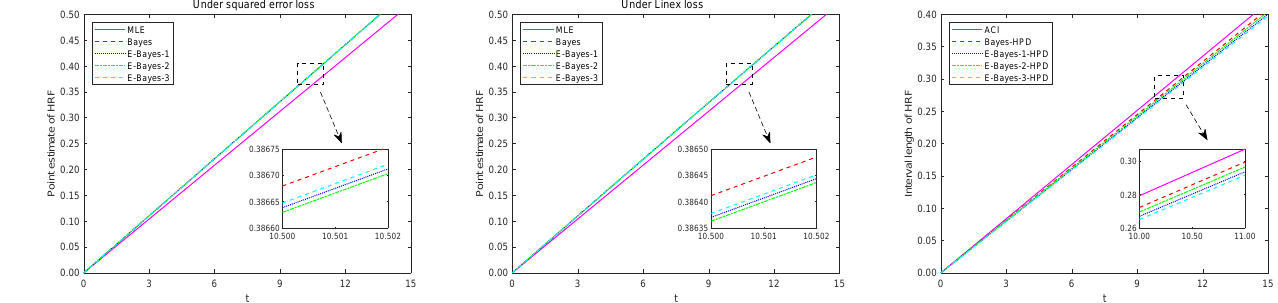
Figure 3. Plots of θ 1 , θ 2 and θ 3 under different prior distributions.